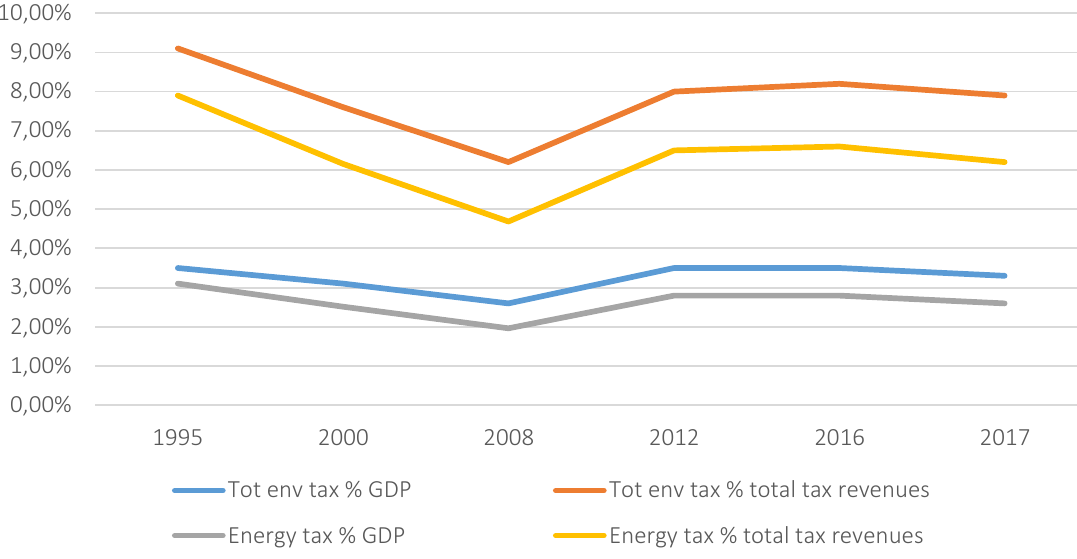
Figure 1. Environmental tax revenues (Italy, trend